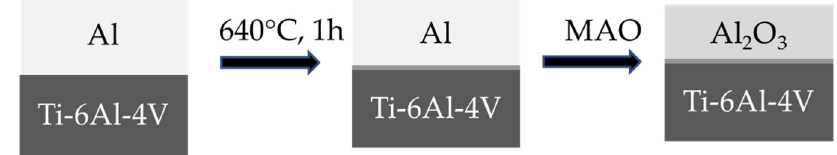
Figure 6. Schematic of deposition of Al layer, followed by heat treatment to form a thin reaction layer at the interface and micro ‐ arc oxidation (MAO) to form alumina.